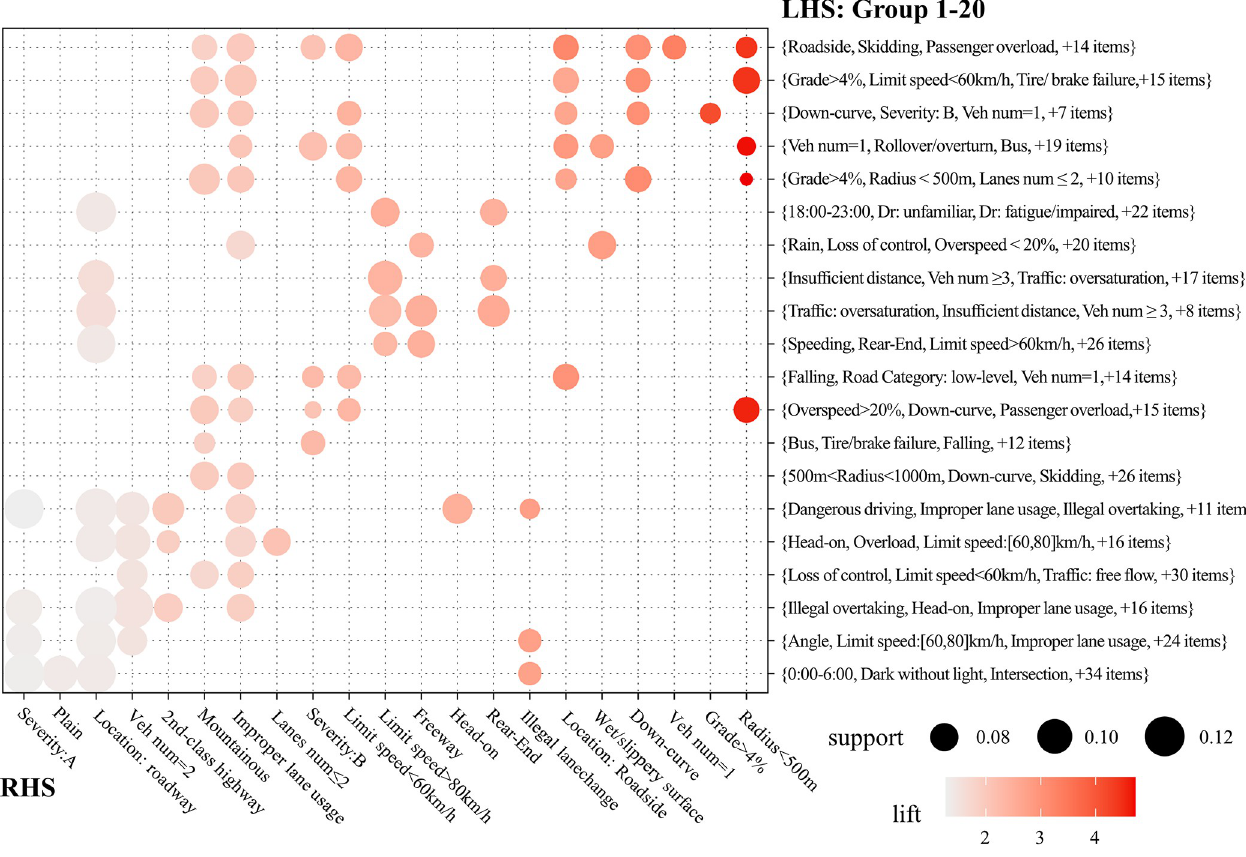
Fig 3. Group matrix-based visualization of 1452